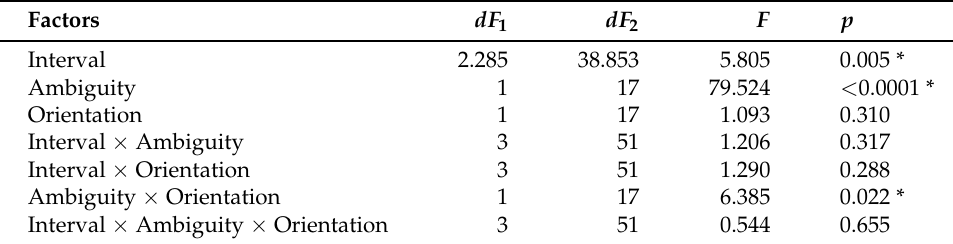
Table 1. Median decision time to the current stimulus, DT [s] (ANOVA Summary).